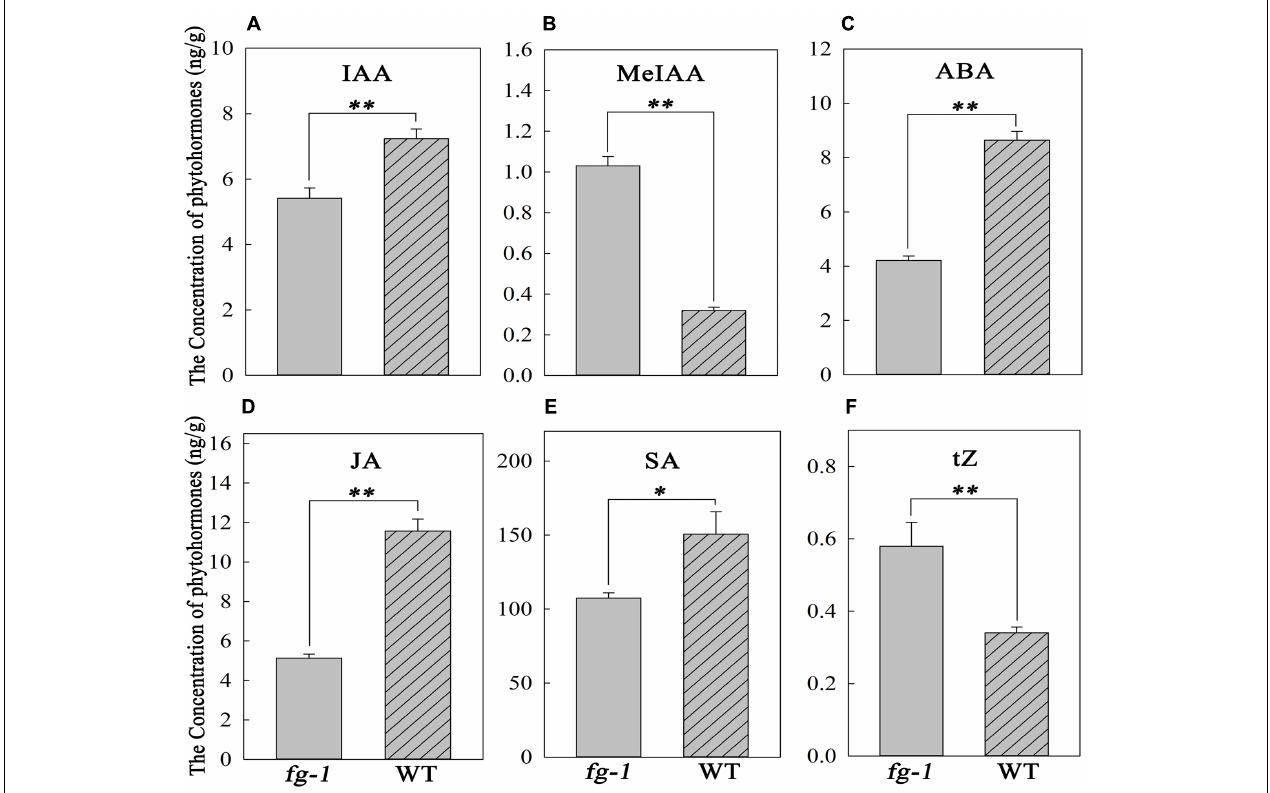
FIGURE 5 | Concentrations of IAA, MeIAA, ABA, JA, SA and tZ in the fg-1 and wild type. An asterisk represents a significant difference ( ∗ p < 0.05 and ∗∗ p < 0.01). (A–F) show the concentrations of IAA, MeJA, ABA, JA, SA and tZ in fg-1 and wild type,